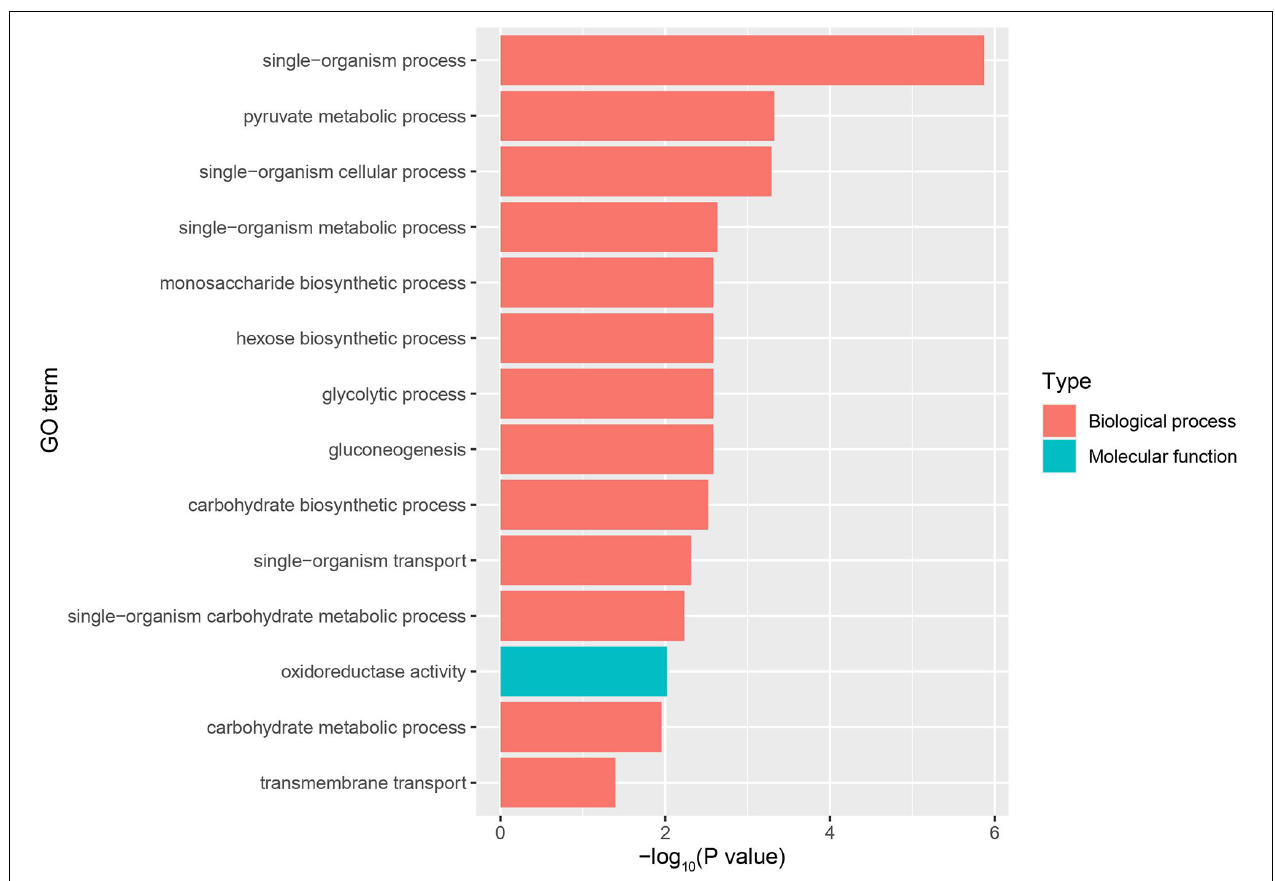
FIGURE 4 | GO enrichment plot of differentially expressed genes (DEGs) between the infected group and the healthy group. The x-axis is the negative logarithm of the p -value, and the y-axis is Goterm. Go Term shows entries for Top14 ( P bonferroni <